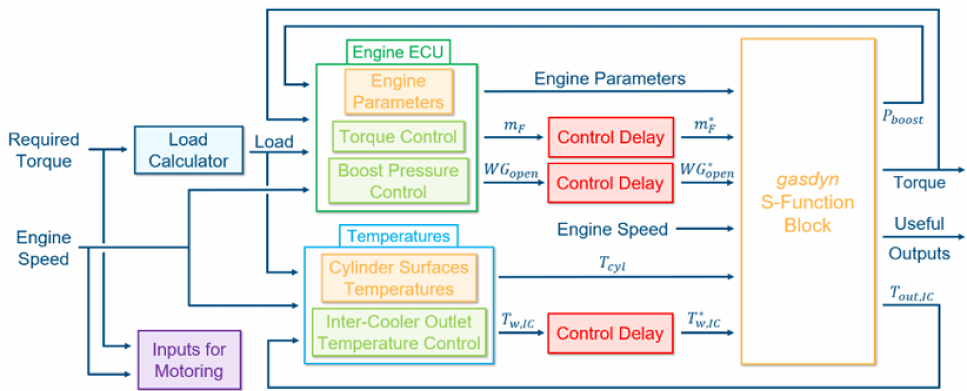
Figure 4. Schematic representation of the IC engine transient